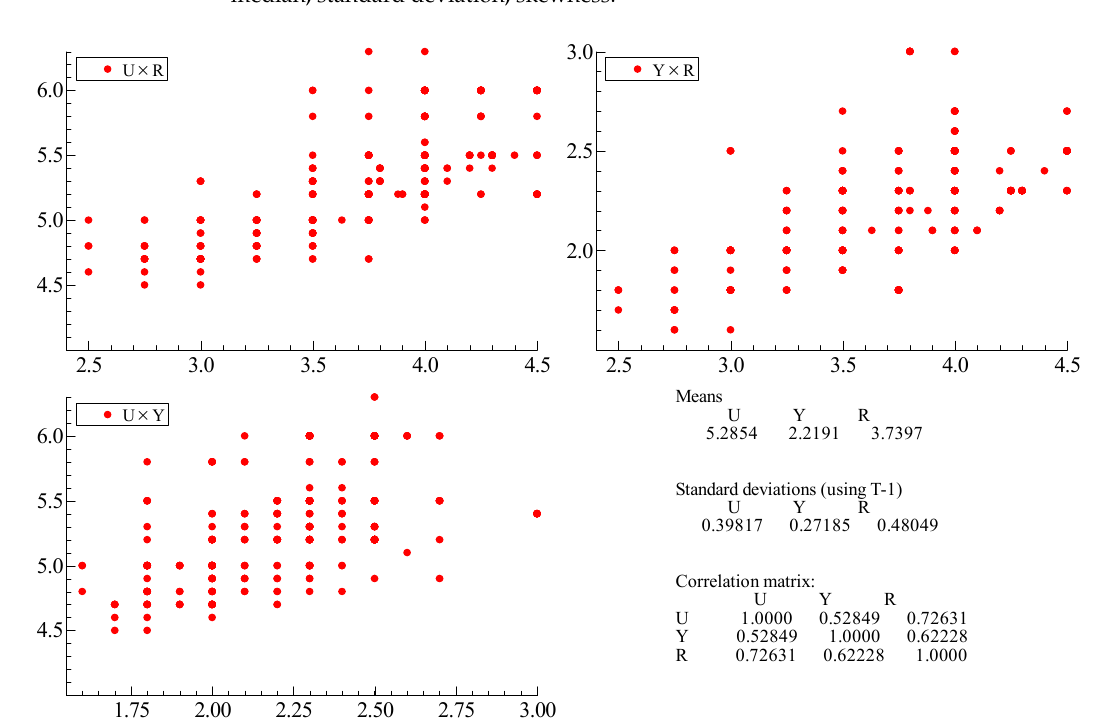
Figure 5. Unconditional correlations among longer-run FOMC forecasts for the Interest Rate (R), the Unemployment Rate (U), and GDP Growth (Y)—January 2012–December